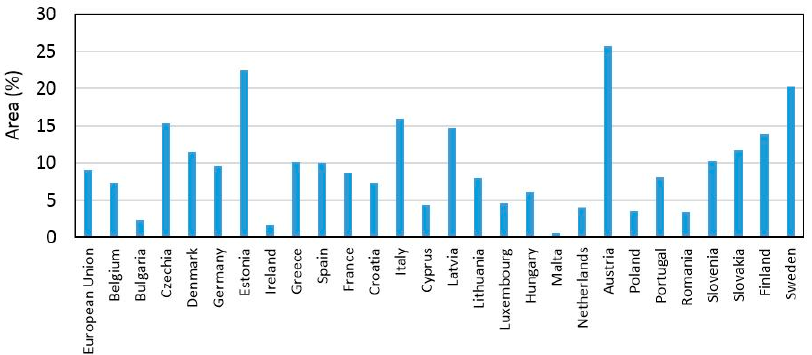
Figure 12. Area of organic farming in the EU as % of the total farming area, data source Eurostat [70].